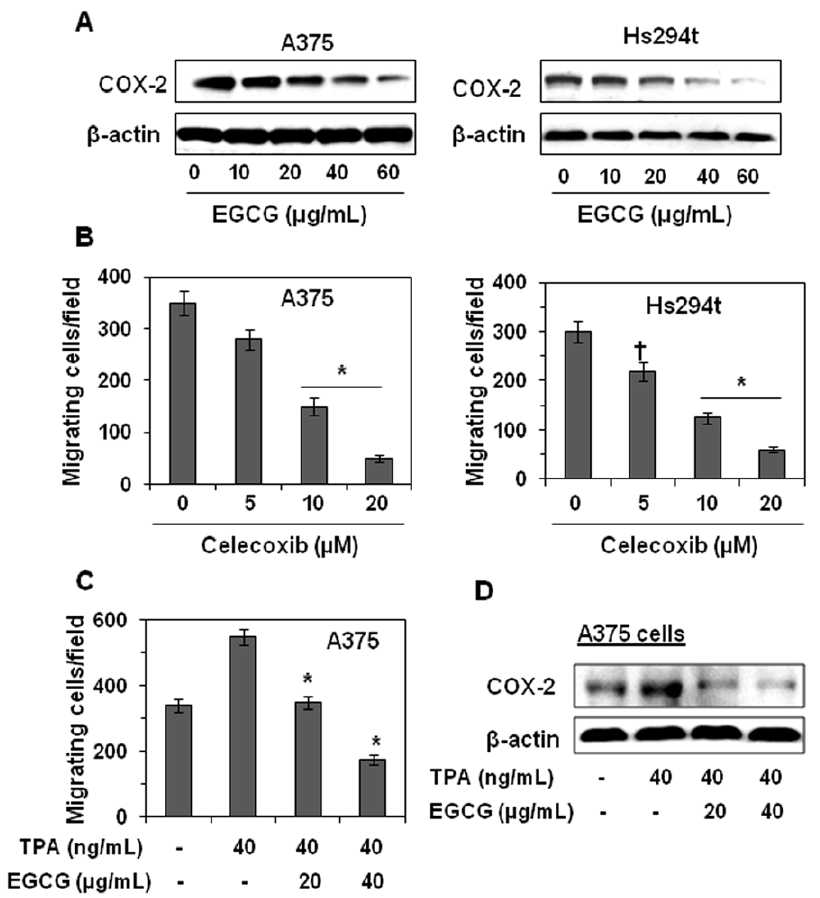
Figure 3. EGCG inhibits invasion of melanoma cells by reducing endogenous COX-2 expression. ( A ) Treatment of A375 and Hs294t cells with EGCG for 24 h resulted in down-regulation of COX-2 protein expression. ( B ) Treatment of A375 and Hs294t cells with celecoxib, an inhibitor of COX-2, for 24 h inhibits melanoma cell migration in a dose-dependent manner. The data are expressed as the mean number of migratory cells 6 SD/ microscopic field. Significant difference versus non-celecoxib-treated control cells, * P , 0.001; { P , 0.05. ( C ) Treatment of A375 cells with EGCG (20 and 40 m g/mL) inhibits TPA (a COX-2 stimulator)-enhanced cell migration capacity. The data on cell migration capacity are summarized in terms of mean number of migrating cells/microscopic field 6 SD, n=3. Significant inhibition versus TPA treatment alone, * P , 0.001. ( D ) EGCG down regulates TPA- induced COX-2 expression in A375 cells. The levels of COX-2 were determined in cell lysates using western blot analysis. doi:10.1371/journal.pone.0025224.g003 (Figure 3D). These data suggest that inhibition of TPA-induced cell migration by EGCG is mediated through the downregu- lation of COX-2 expression.